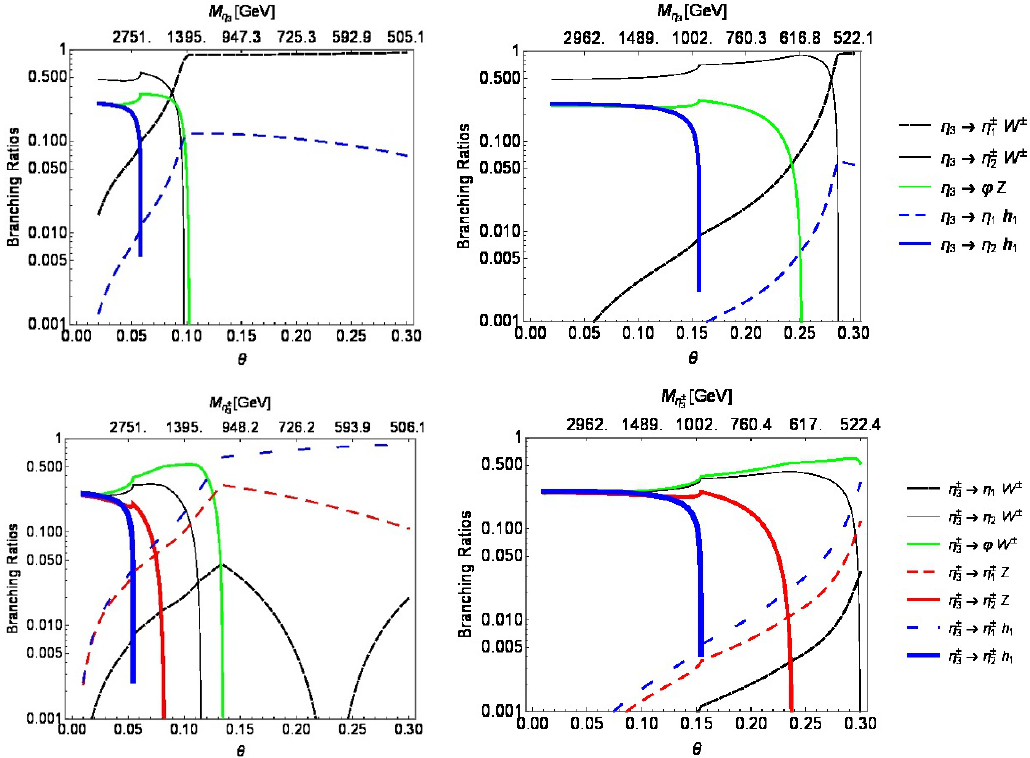
Figure 2 . Branching Ratios of (cid:17) 3 (top) and (cid:17) (cid:6)